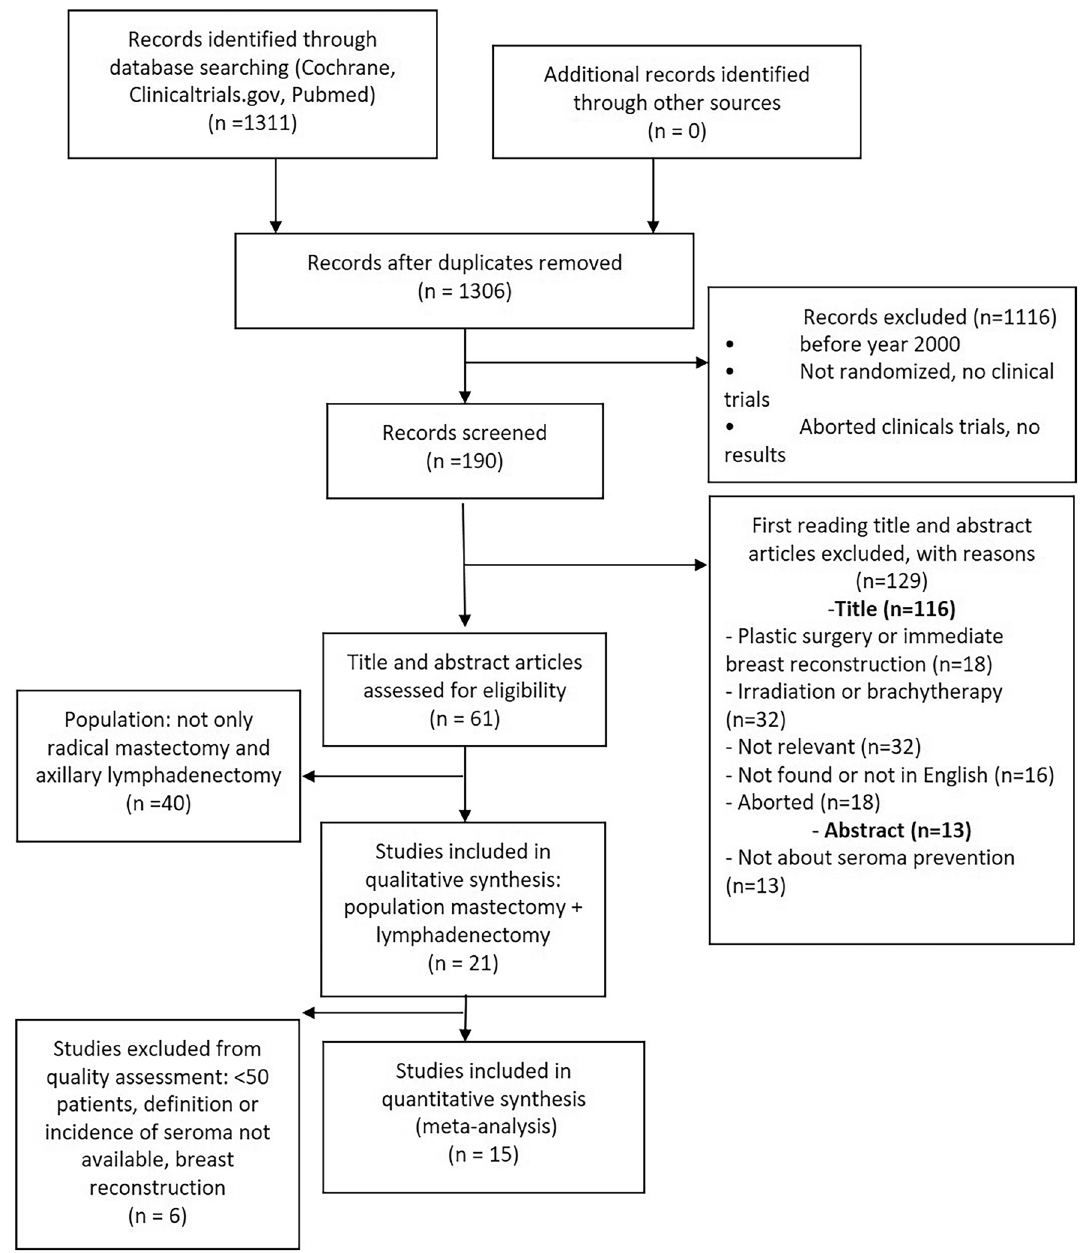
literature screening and